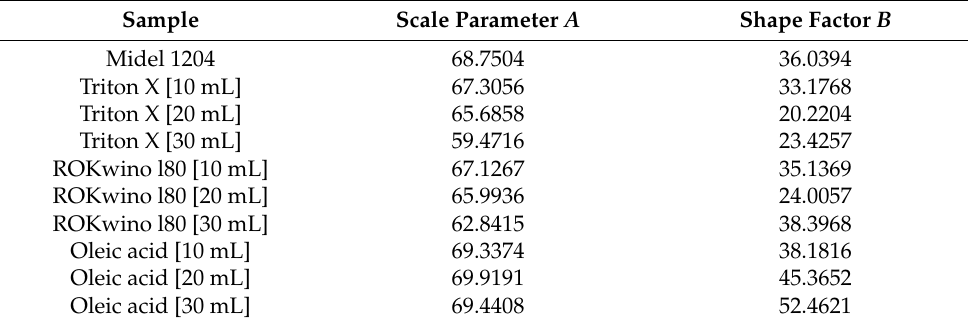
Table 6. Values of shape factor and scale parameter for the Weibull probability plots.